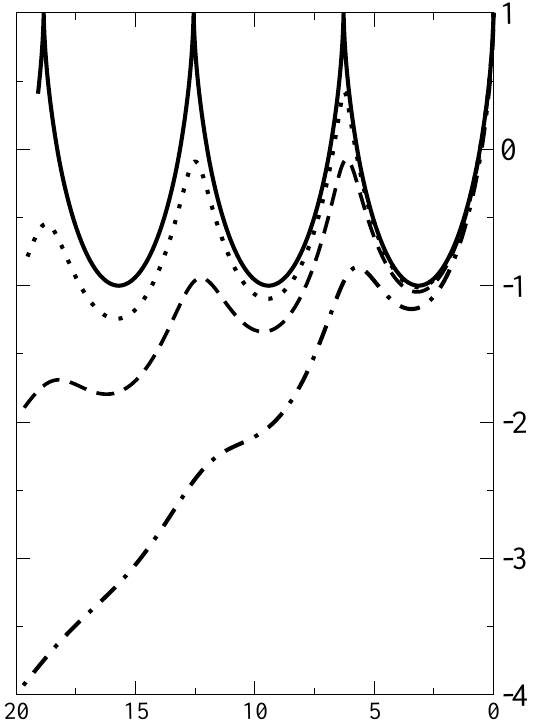
Fig. 3. Lagrangian trajectory of a particle described by Eqs. (28, 29) with Rayleigh friction values of: r/f= 0 (full line), 0.05 (dotted) , 0.1 (dashed) and 0.2 (dashed-dotted) (x-direction upward, y-direction to the left).